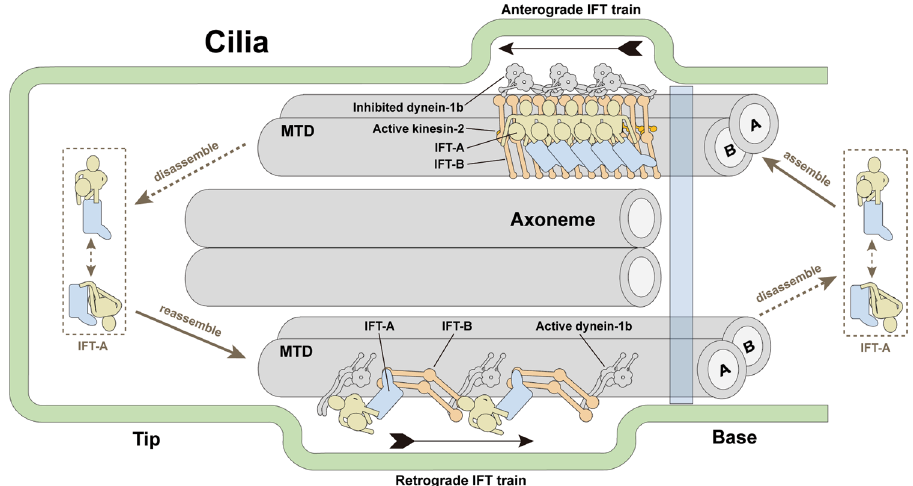
Fig. 6 | Schematic diagramof IFT-A cycle. IFT-A complexes from the assembly of freshly expressed IFT-A subunits and the disassembly of retrograde IFT trains are concentrated in the basal bodies. Preassembled bimodular IFT-A are incorporated intoanterogradeIFTtrainbybendingatthehingeregionsandtwistsofthe fl exible TPRs. After reaching the tip, IFT-A and IFT-B dissociate from anterograde train, likely through adjustments at the hinge regions and the fl exible TPRs to